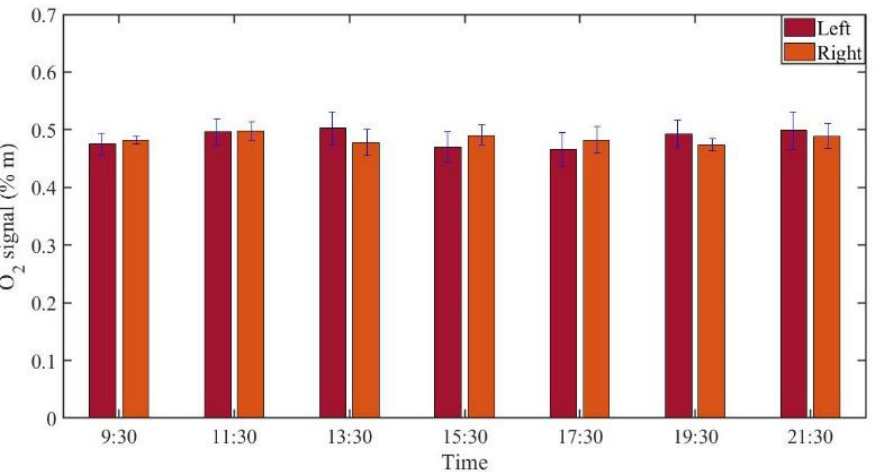
Figure 11. The changes of measured oxygen signal from a frontal sinus of the healthy volunteer 1 during one day.